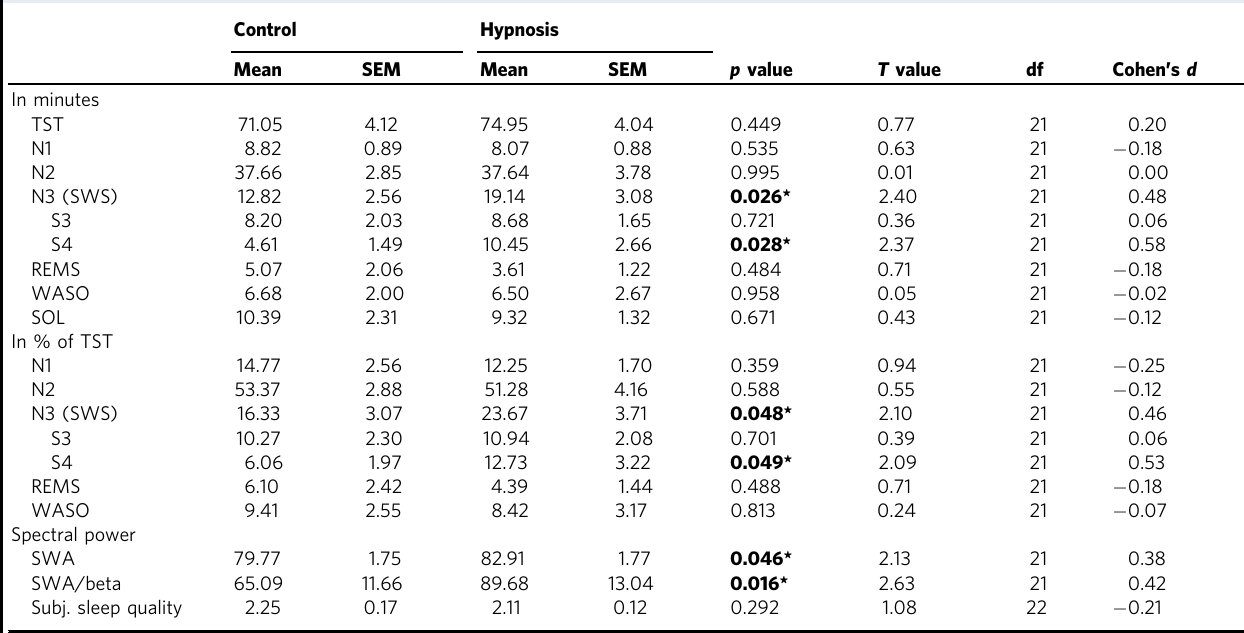
Table 1 Comparison of sleep parameters between the Hypnosis and Control condition. Control